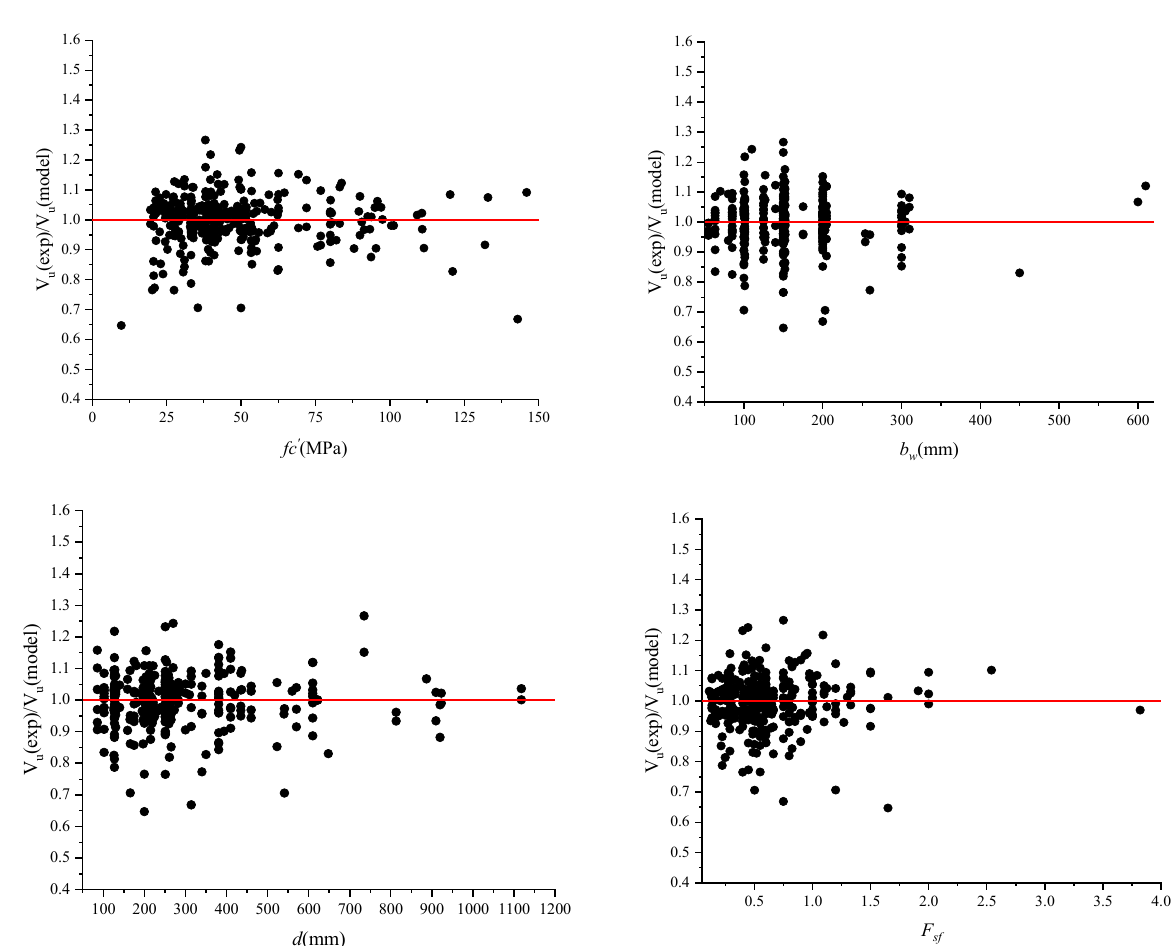
Figure 8. The relationship between the shear input variables and the ratio of experimental to model shear strength.